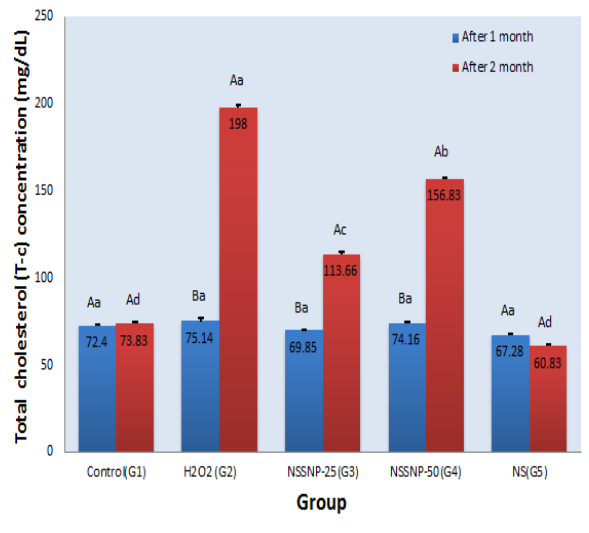
Figure 4. Effect of two concentrations of Nigella sativa with Nigella 3 expressed as mean±SE (n= 8). Various capital letters denote significant differences at P<0.05 between